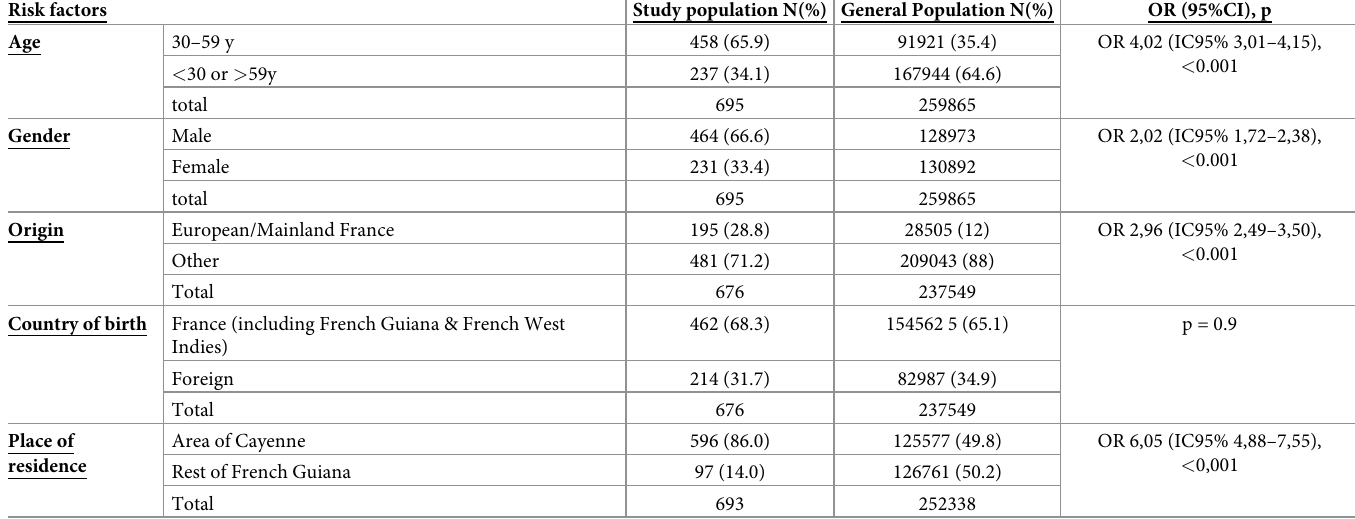
Table 2. Determinants of patients with Q fever compared to general population in French Guiana, 2007–2017 (Source: Insee census 2015).